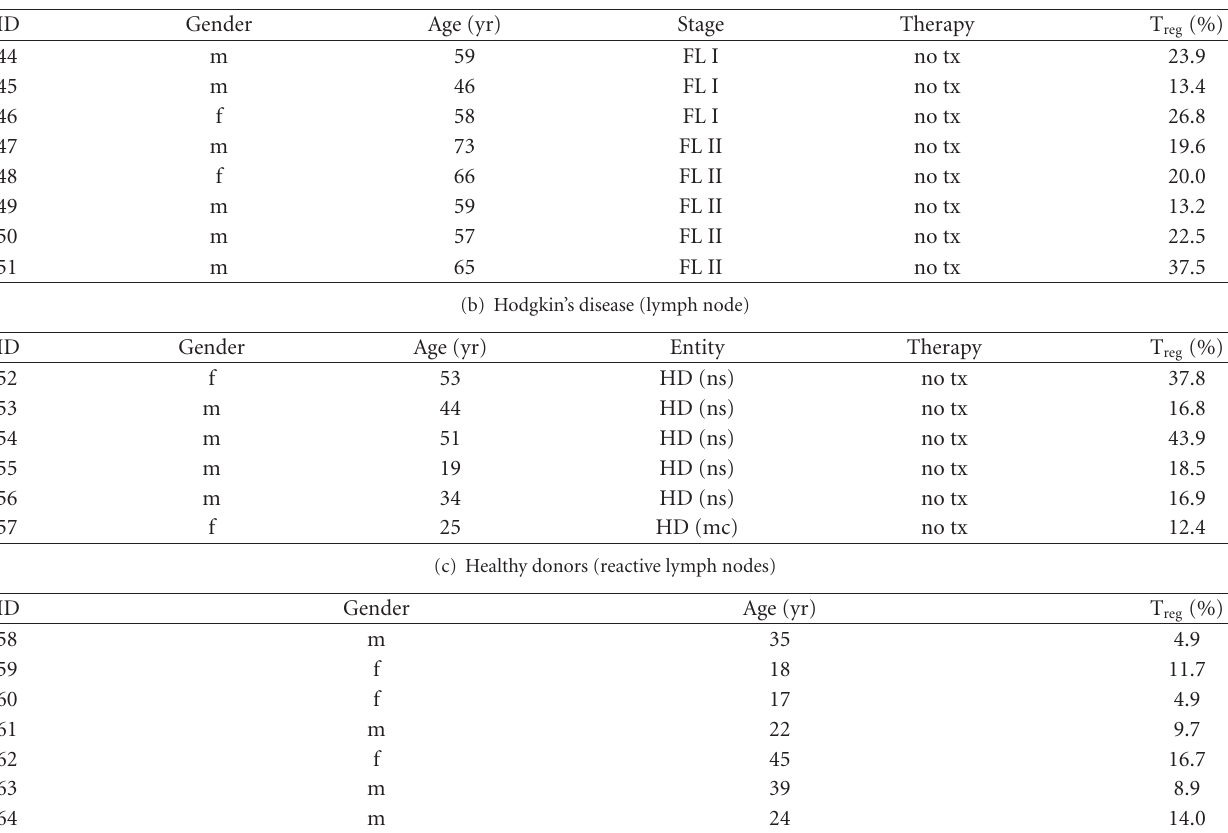
Table 2: Patient characteristics for T reg -cell assessment in lymph node